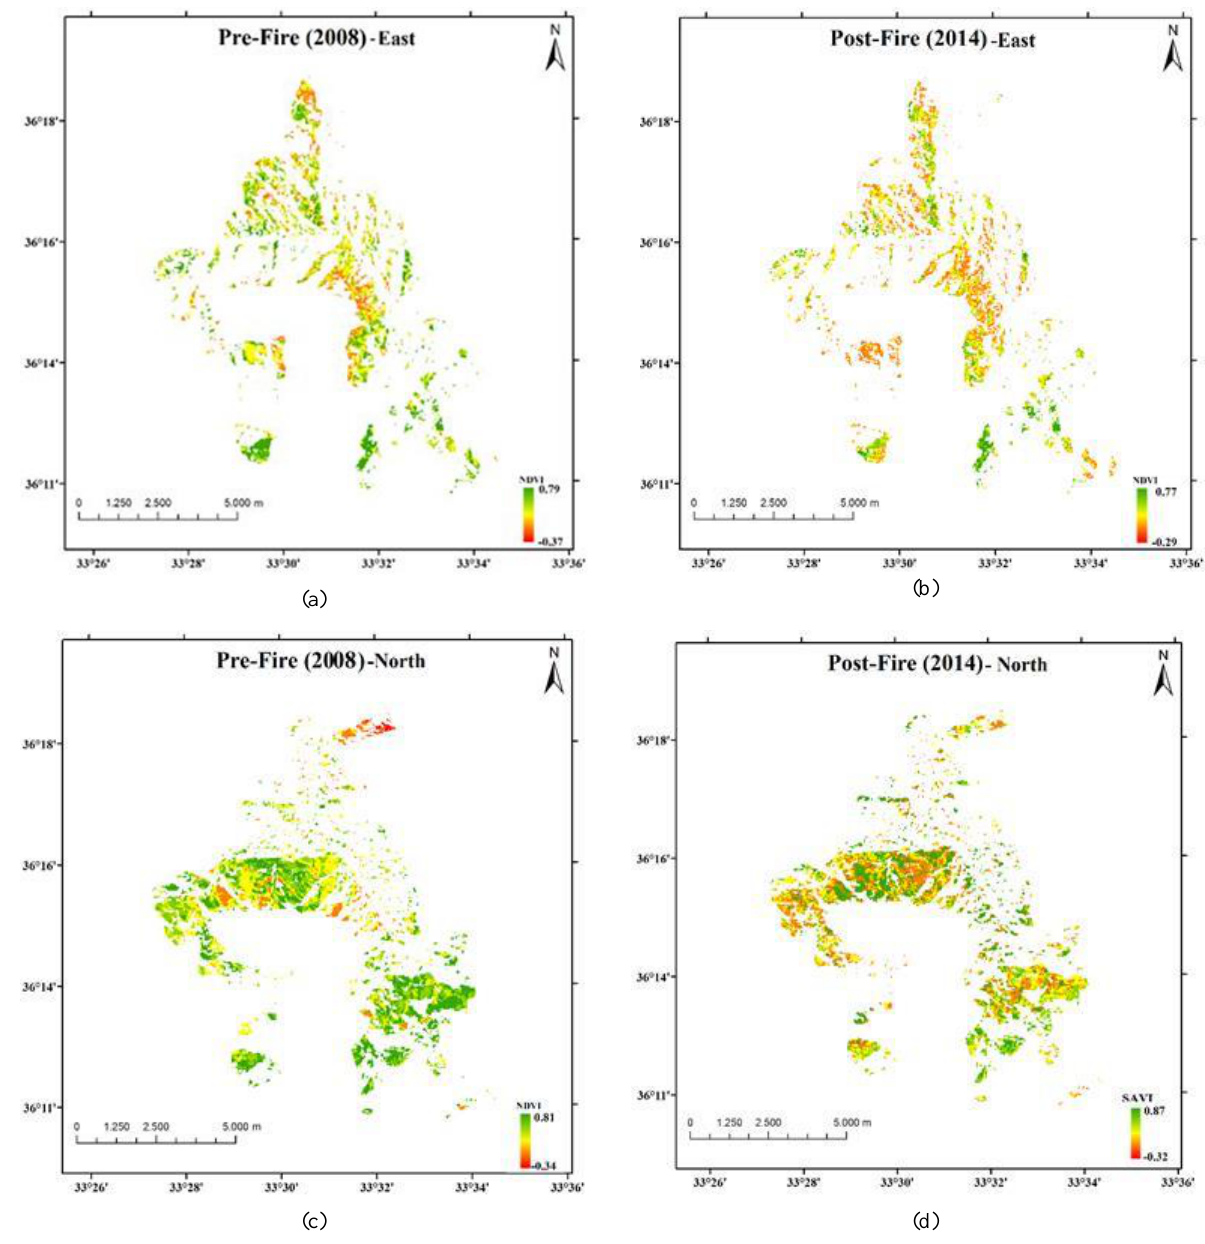
Figure 3. NDVI change maps for slope aspects (a) 2008 East, (b) 2014 East, (c) 2008 North, (d) 2014